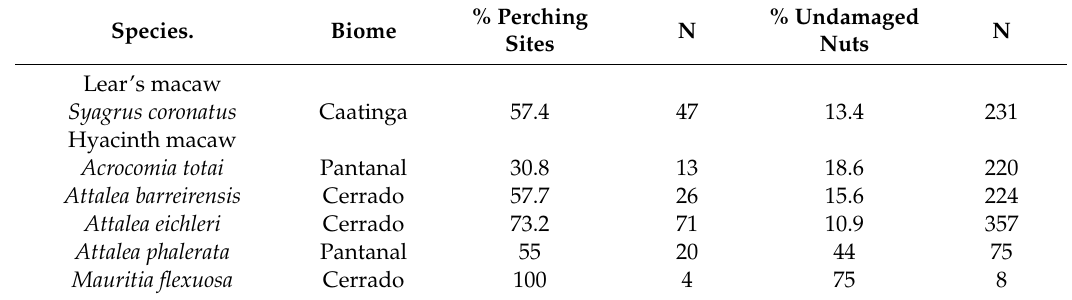
Table 4. Percentage of perching sites where macaws dispersed undamaged nuts, and the percentage of undamaged nuts found under these perching sites for each palm species. % Species. Biome